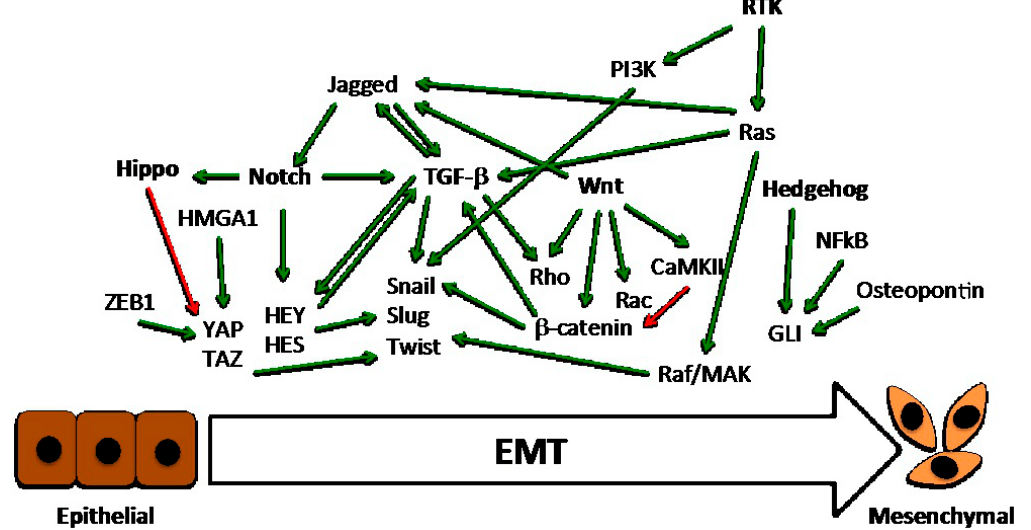
Figure 2. Schematic overview of the main critical endogenous pathways involved in breast cancer EMT. Green and red arrows indicate positive and negative regulation, respectively. The six pathways are in bold, and are further detailed in the text.